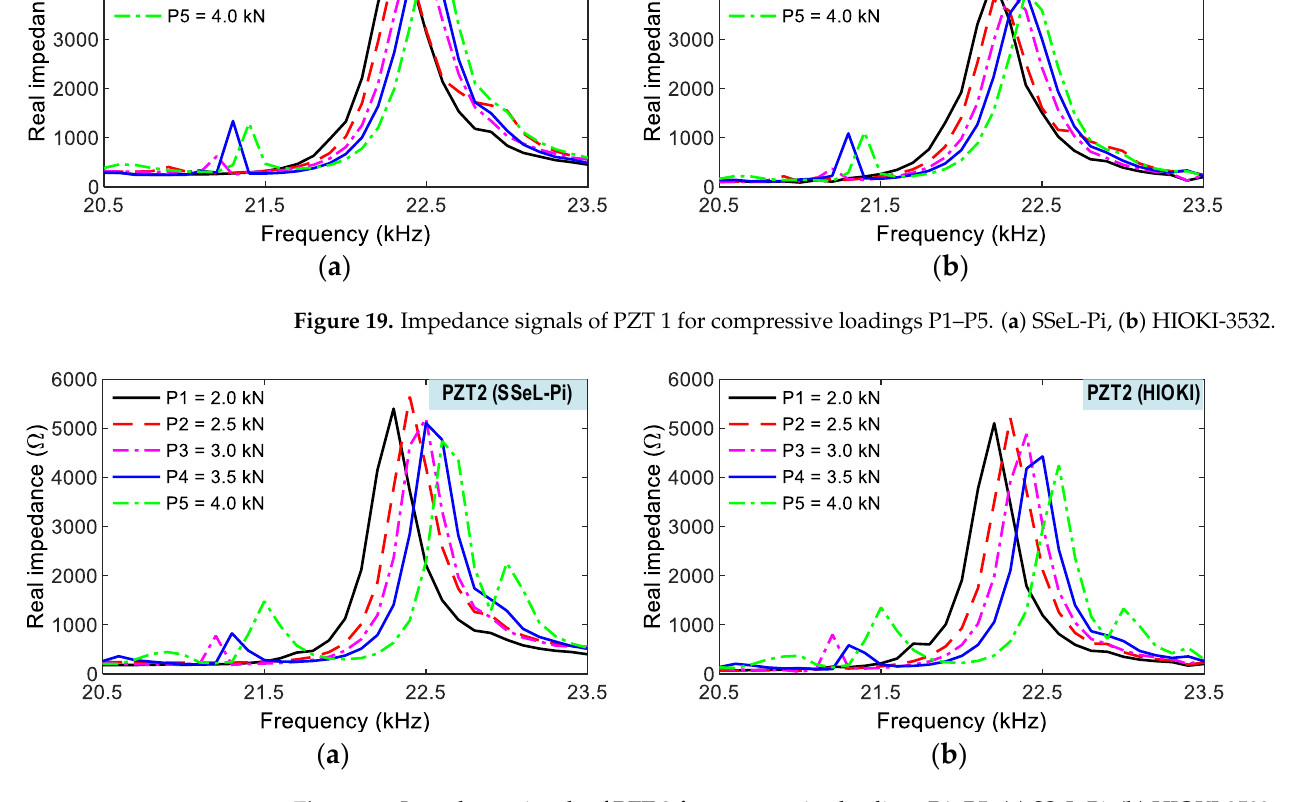
Figure 20. Impedance signals of PZT 2 for compressive loadings P1 – P5. ( a ) SSeL-Pi, ( b ) HIOKI-3532.